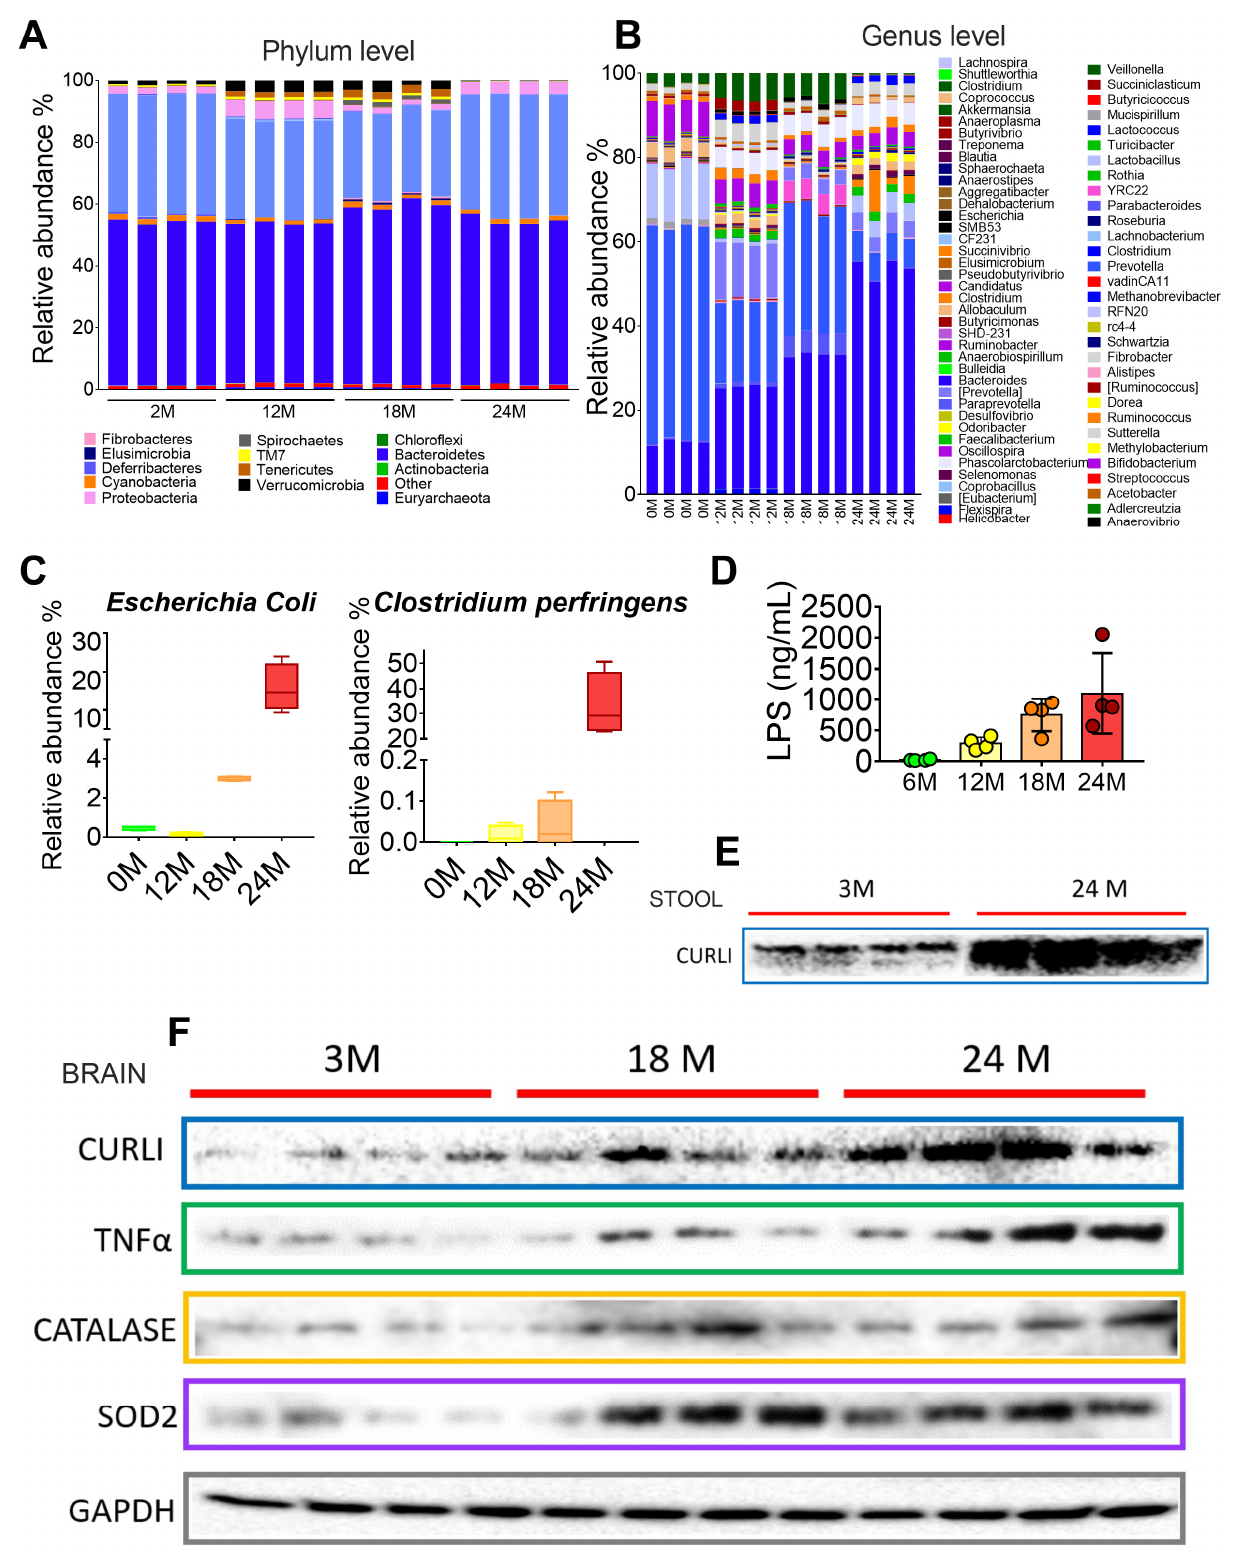
Figure 5. Aging modifies the intestinal microbial profile and increases inflammation in rats. Relative abundance of the intestinal microbiota at the level of phylum ( A ), genus ( B ), and species ( C ), and serum lipopolysaccharide ( D ). Abundance of curli protein in feces ( E ). Western blot analysis of markers of inflammation and oxidative stress in the brain of rats at different ages ( F ).